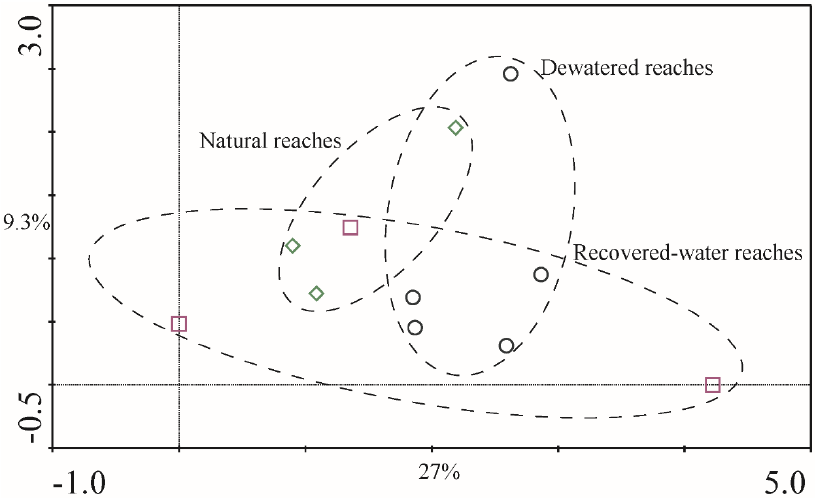
Figure 7. Ordination diagrams of macroinvertebrates under the runoff regulation grouping from QYR in 2011.